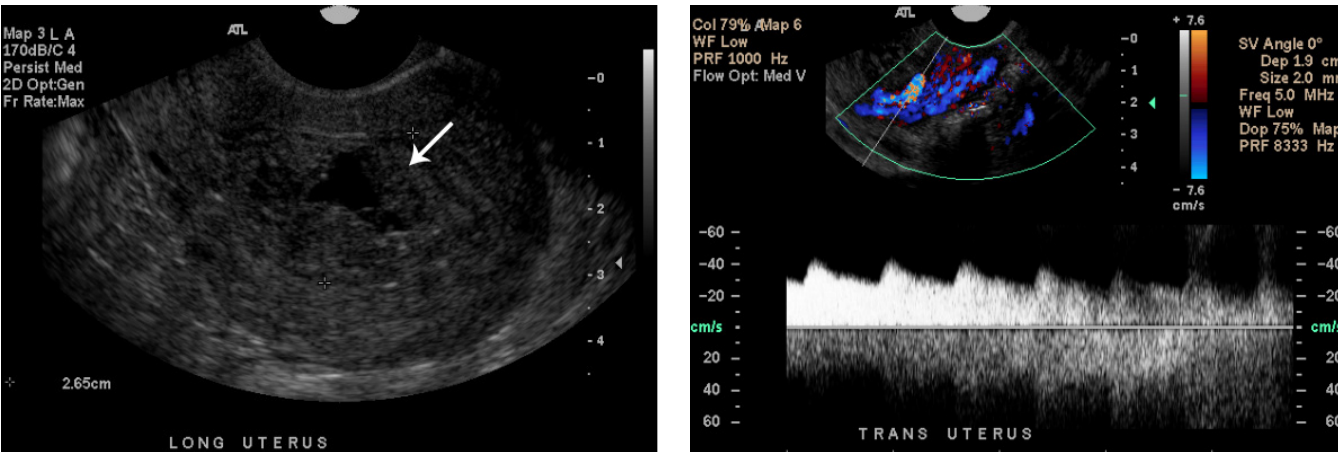
Figure 1 . Ultrasonography of uterus in long axis showing enlarged endometrial cavity (2.65 cm) with irregular clot.